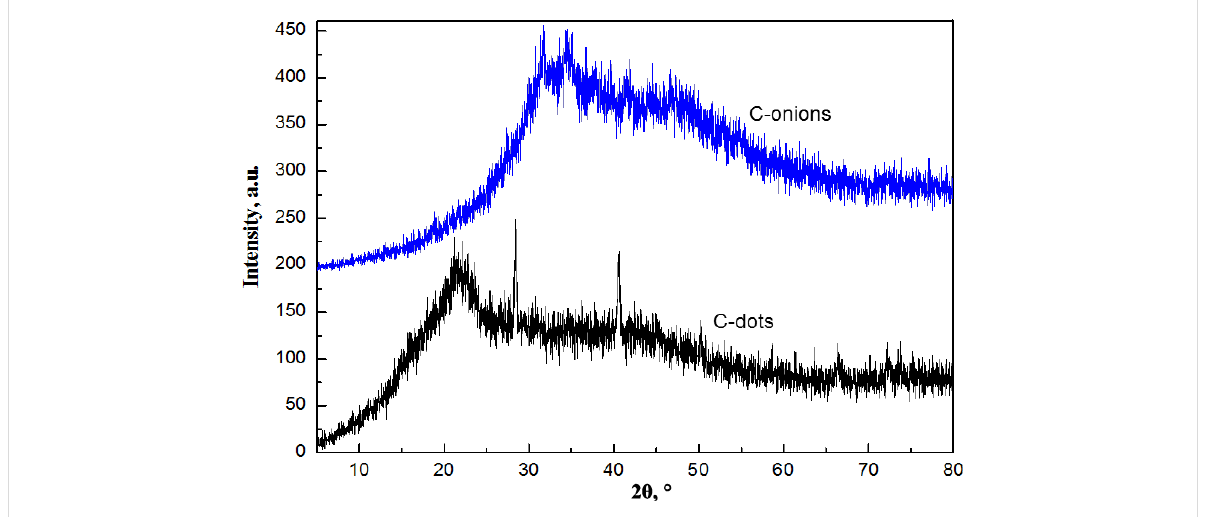
Figure 4: XRD patterns of C-NPs obtained from tomatoes through carbonization in aqueous (C-dots) and NaOH 30% (w/v) (C-onions) media.